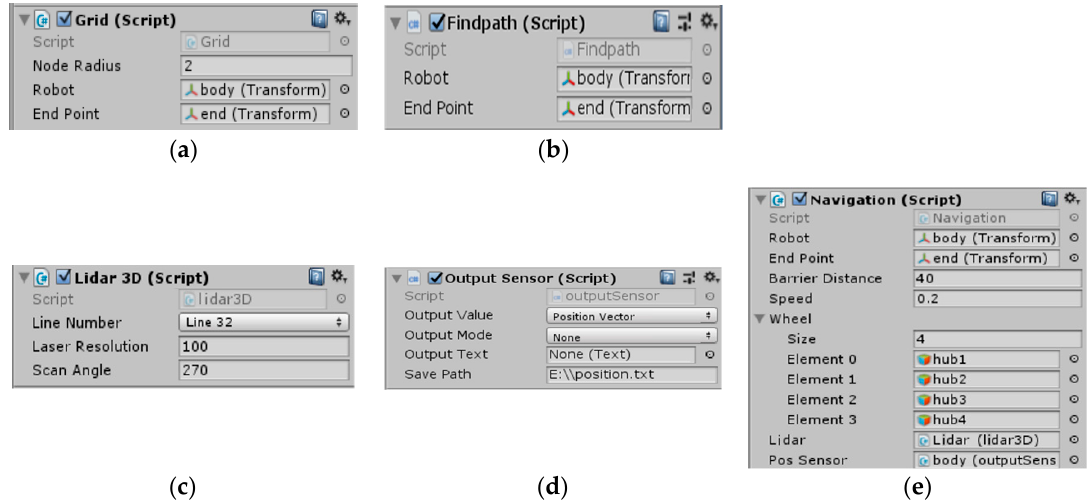
Figure 29. The addition of navigation algorithms: ( a ) the addition of grid script; ( b ) the addition of Findpath script; ( c ) the addition of LiDAR 3D script; ( d ) the addition of output sensor script; ( e ) the addition of navigation script.